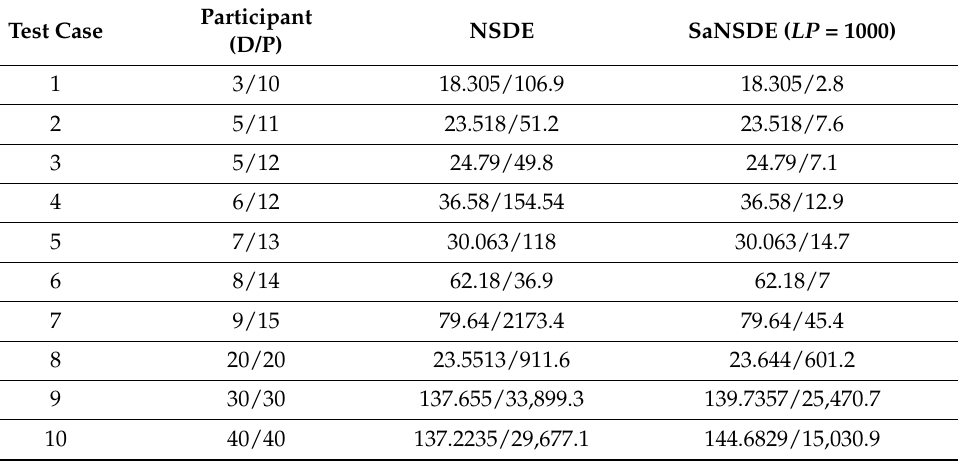
Table 19. Average fitness values and average number of generations for NSDE and SaNSDE with algorithmic parameter LP =